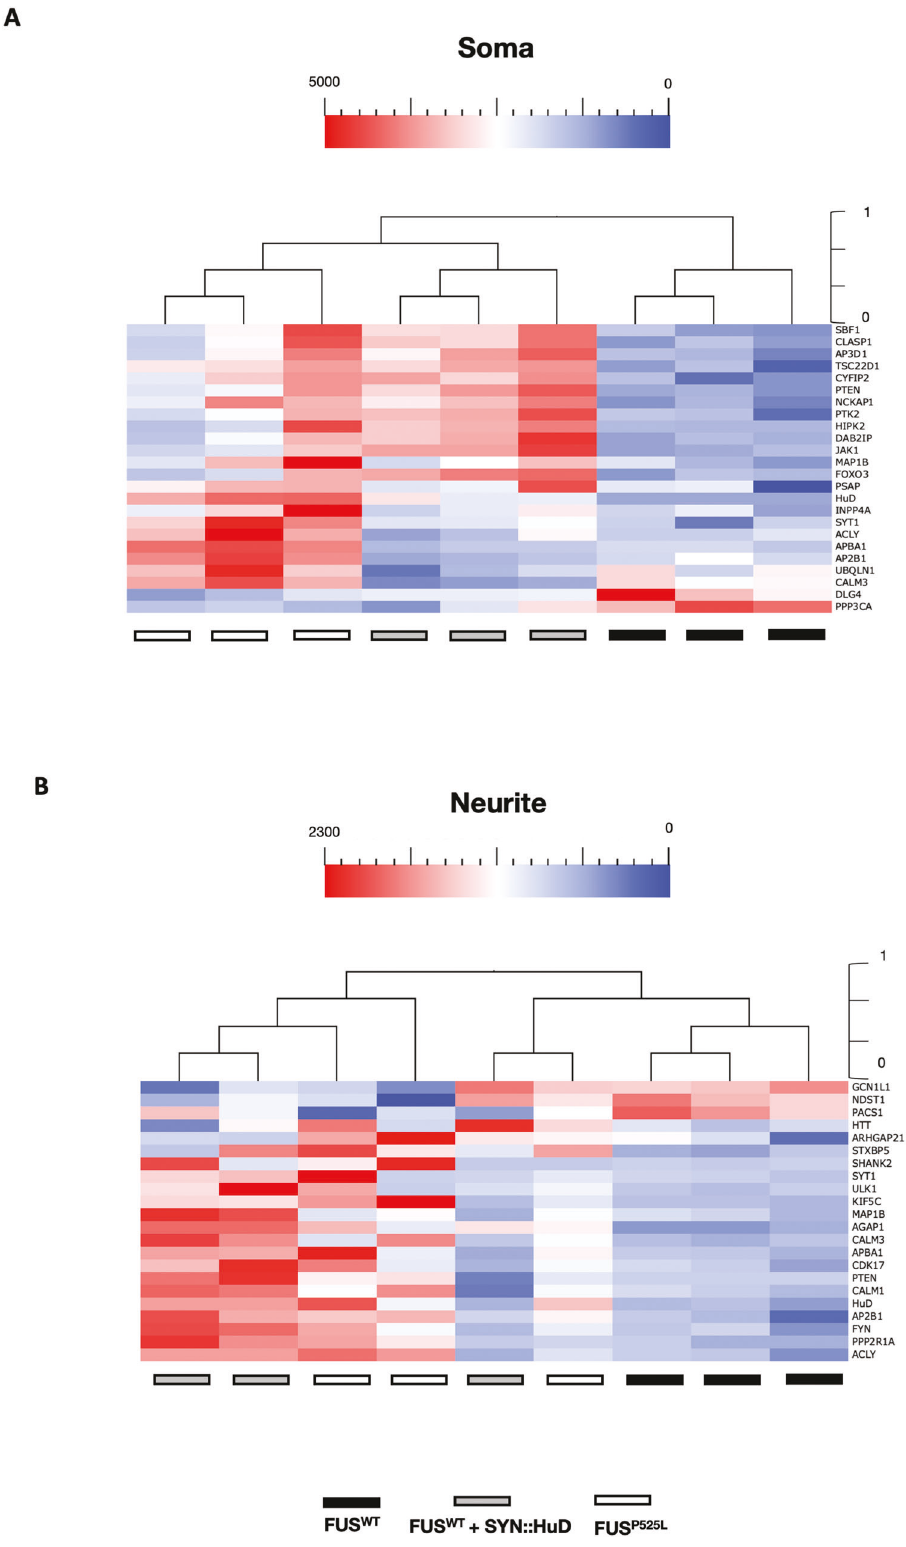
Fig. 5 Differentially expressed genes in soma and neurite of FUS WT , FUS P525L , and FUS WT SYN::HuD MNs. A , B Unsupervised cluster representing the RNA molecules count of differentially expressed genes in the cell body ( A ) or neurite ( B ) compartment of iPSC-derived FUS WT , FUS P525L , and FUS WT SYN::HuD MNs. Plotted values correspond to normalized RNA molecules as described in the Methods section. Red, higher abundance; blue, lower abundance.